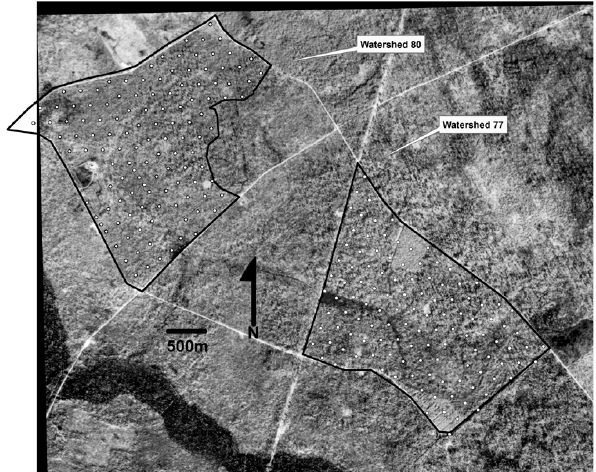
Fig. 2. Locations of vegetation sampling plots placed on watersheds 77 and 80 in 1991 and summarized in this